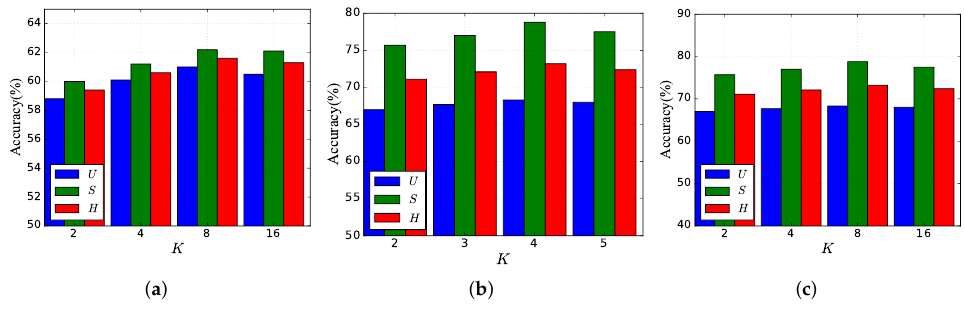
Figure 3. The effect of hyper-parameter K : ( a ) CUB; ( b ) AWA2; and ( c ) FLO. Hyper-parameter λ : We evaluate the effect of λ as shown in Figure 4. This hyper- parameter controls the regression loss of the prototype projected back to the attribute space, and by the same token, the prototype is also controlled by the adversarial loss. If this hyper-parameter is too large, it will lead to a lower percentage of adversarial loss, which will lead to lower authenticity of the final synthesized features. If this hyper-parameter is too small, then it will lead to a lower correlation between the prototype and the attributes. Thus, λ is set to one to achieve the best results on all datasets.